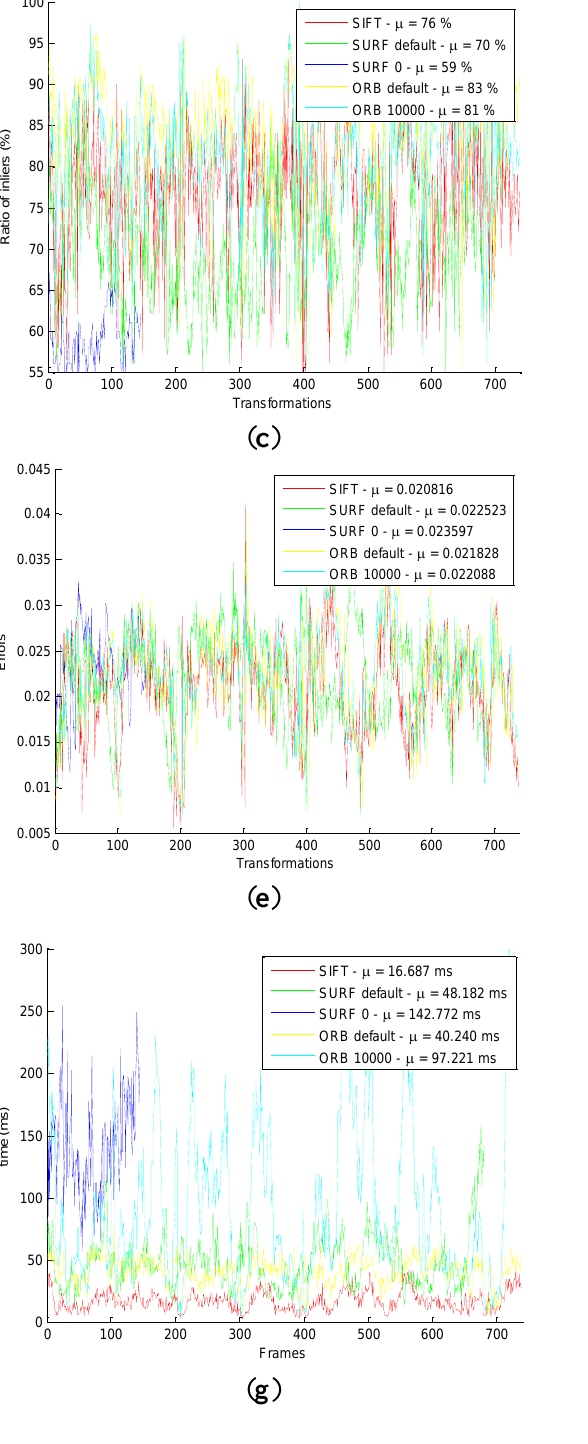
Figure 8. Results of motion transformation estimation for original and improved method on all images. ( a ) The number of original inliers. ( b ) The number of improved inliers. ( c ) The proportion of original inliers. ( d ) The proportion of improved inliers. ( e ) Deviation for original method. ( f ) Deviation for improved method. ( g ) Time for original method. ( h ) Time for improved